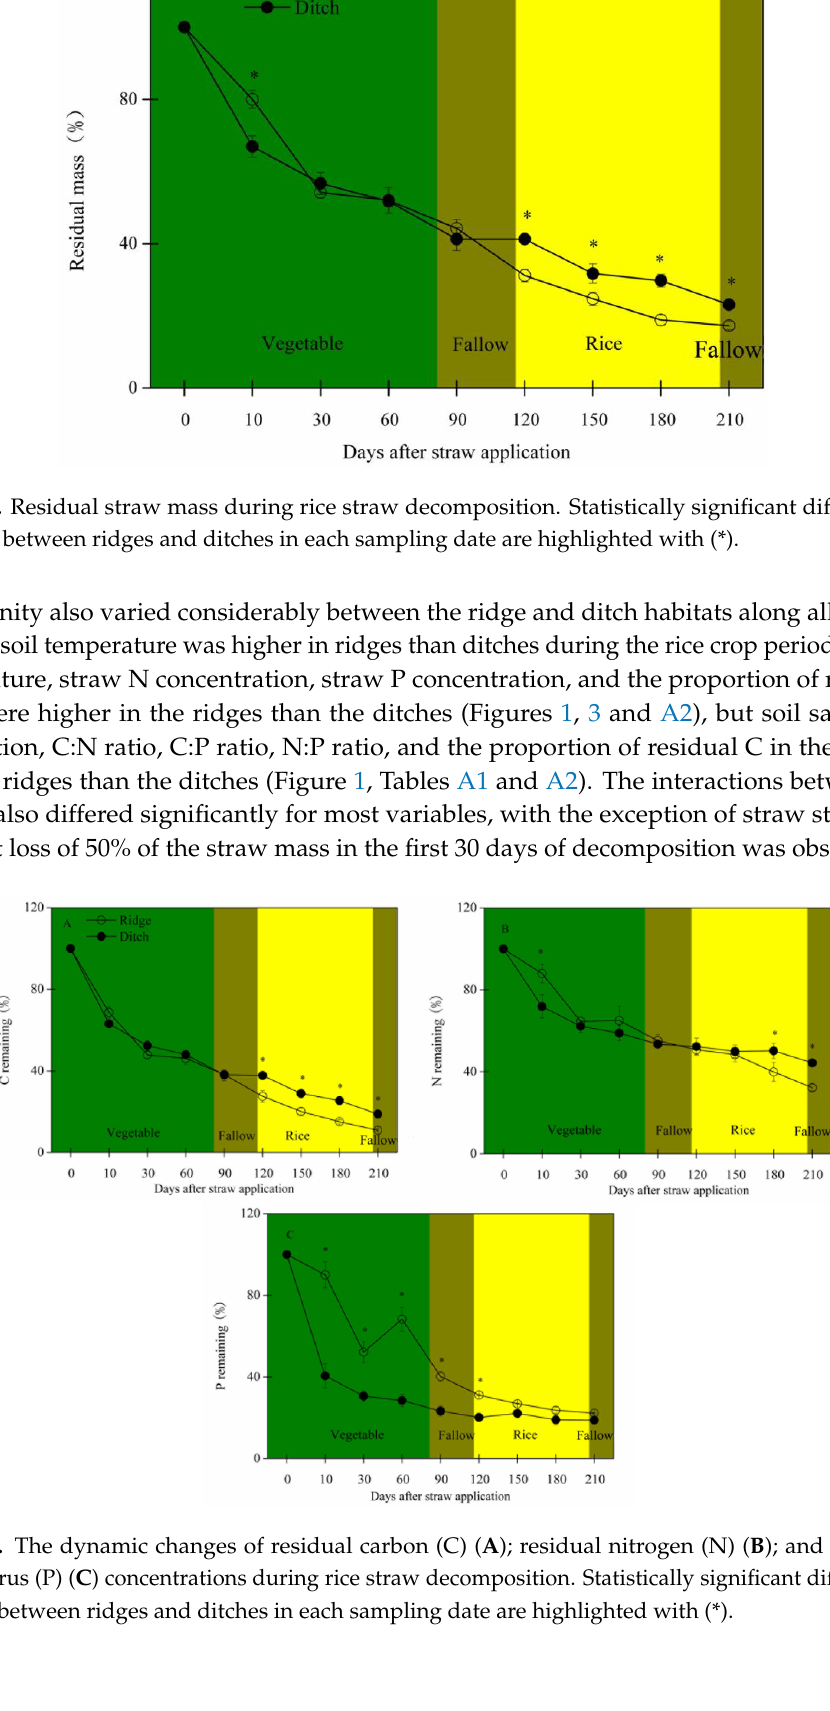
negatively with soil temperature ( R = −0.85, p < 0.001), straw N concentration ( R = −0.88, p < 0.001), and straw N:P ratio ( R = −0.36, p = 0.006), and positively with soil salinity ( R = 0.32, p = 0.014), straw C concentration ( R = 0.53, p < 0.001), straw C:N ratio ( R = 0.86, p < 0.001), and straw C:P ratio ( R = 0.28, p = 0.025) (Table A3). The proportions of residual C, N, and P in the straw (% of the initial content) were correlated negatively with temperature ( R = −0.86, p < 0.001; R = −0.72, p < 0.001; R = −0.62, p < 0.001; respectively), straw N concentration ( R = −0.90, p < 0.001; R = −0.69, p < 0.001; R = −0.51, p < 0.001; respectively), and straw N:P ratio ( R = −0.28, p = 0.025; R = −0.33, p = 0.010; R = −0.77, p < 0.001; respectively), but positively with the proportion of residual mass ( R = 0.99, p < 0.001; R = 0.93, p < 0.001; R = 0.76, p < 0.001; respectively) and straw C:N ratio ( R = 0.90, p < 0.001; R = 0.67, p < 0.001; R = 0.43, p = 0.001; respectively) (Table A3). The proportion of residual C and N in the straw were positively correlated with soil salinity ( R = 0.35, p = 0.008; R = 0.31, p = 0.016; respectively) and straw C concentration ( R = 0.62, p < 0.001; R = 0.47, p < 0.001; respectively). The proportion of residual C in the straw was negatively correlated with straw P concentration ( R = −0.23, p = 0.019). The proportion of residual N in the straw was positively correlated with litter P concentration ( R = 0.43, p = 0.001). Finally, the straw C:P ratio was correlated positively with the proportion of residual C in the straw ( R = 0.38, p = 0.004), but negatively with the residual N in the straw ( R = −0.36, p = 0.006). More N and P were released during the rice crop (% of the initial content) from the straw in the ridges than from the straw in the ditches; the straw applied to the ridges released 18% of the initial N contents and 9% of the initial P contents, whereas the straw applied to the ditches released 8% of the initial N contents and 2% of the initial P contents (Figure 4).